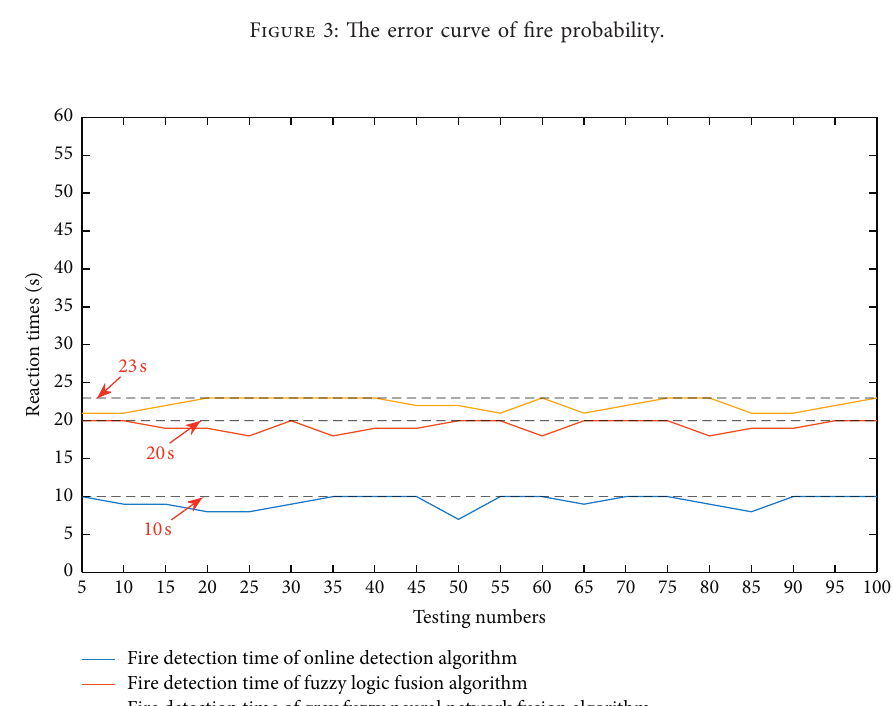
Figure 4: Comparison diagram of detection time of three fire detection